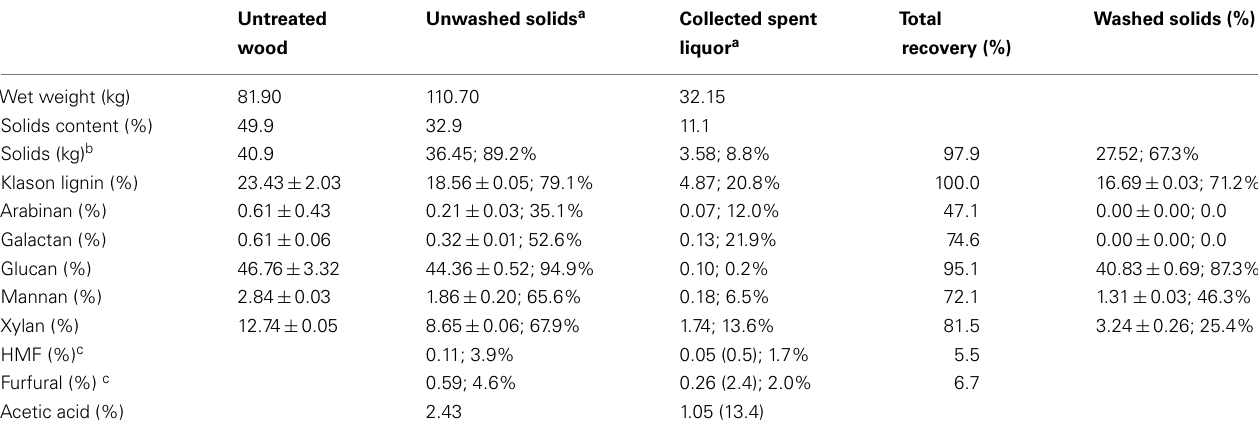
Table 1 |Wood component recoveries from pilot-scale SPORL pretreatment of poplar NE222 along with the chemical composition of the untreated NE222